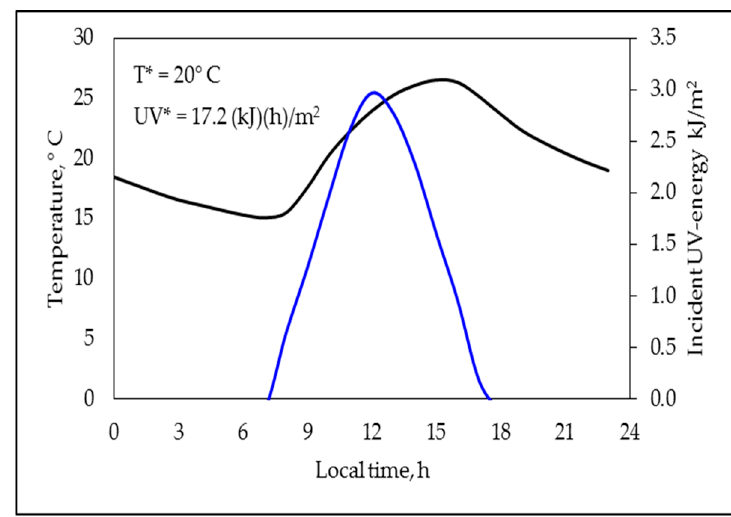
Figure 3. Representative profiles for temperature (black line) and incident UV energy (blue line), as well as the T* and UV* values, corresponding to the “twin experiment”.